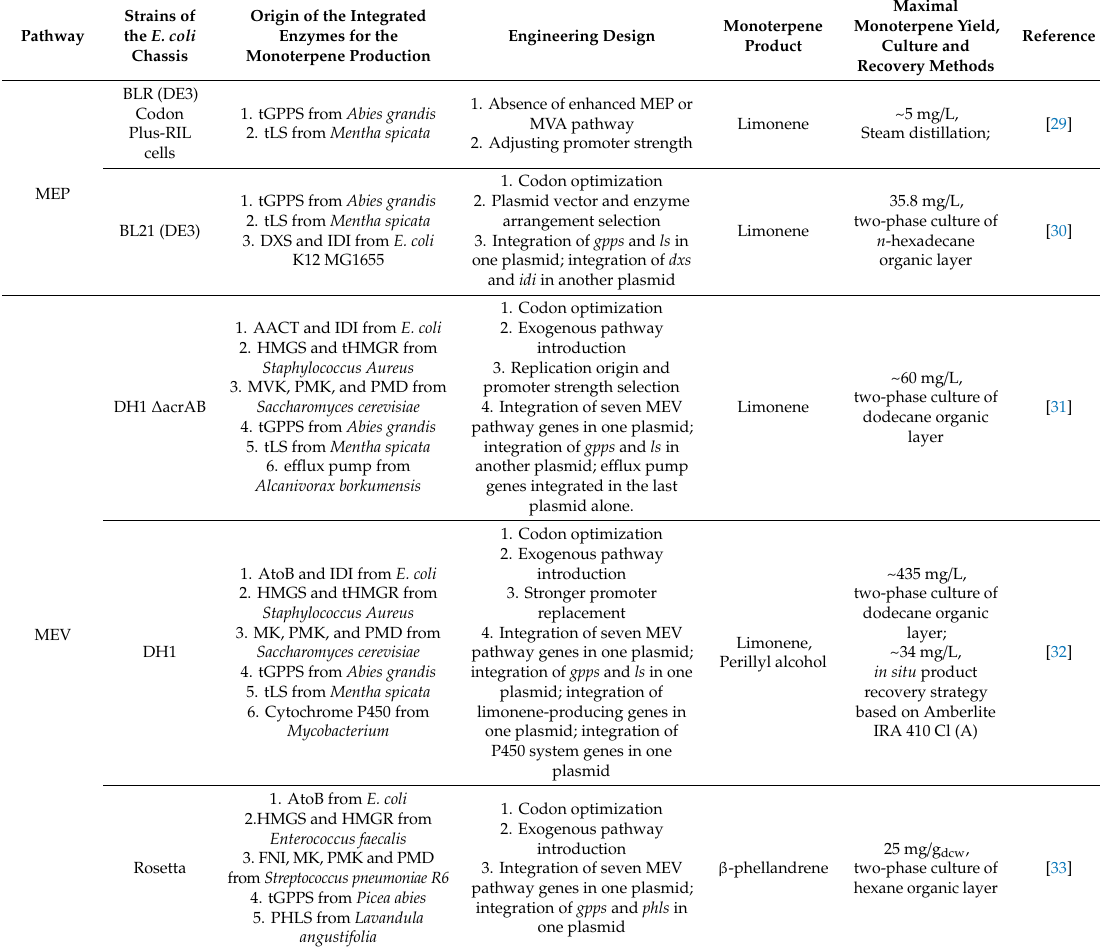
Table 1. Strategies used for monoterpene